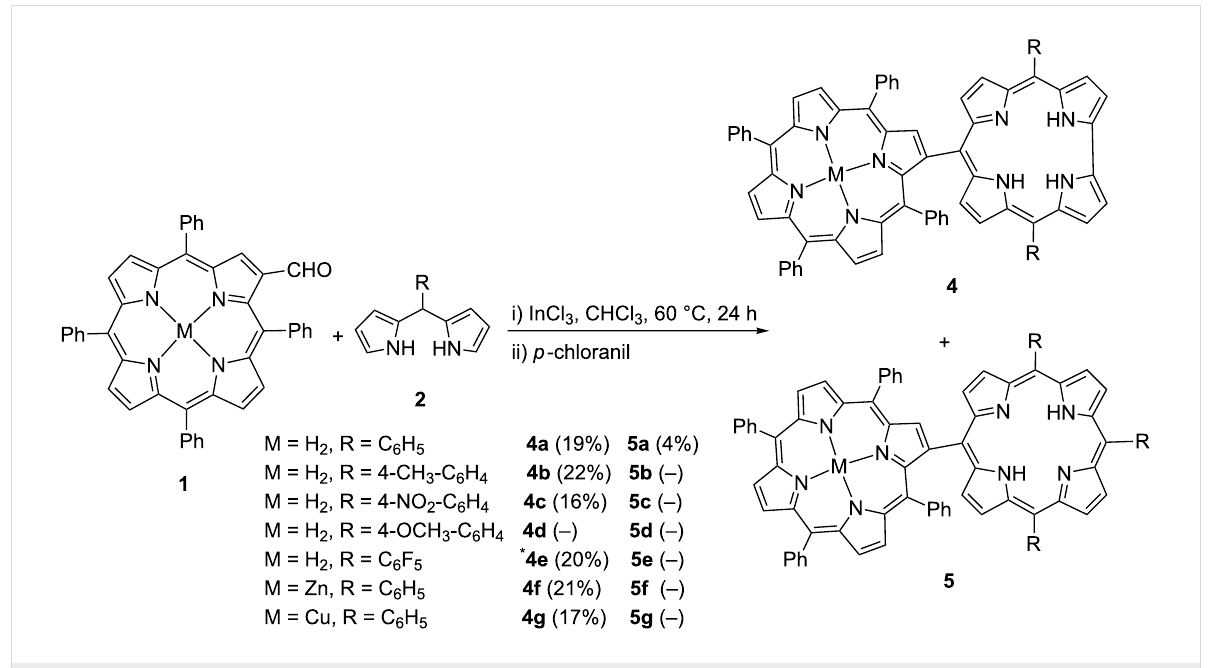
the reaction to produce the hybrid compound 4g in 17% yield (Scheme